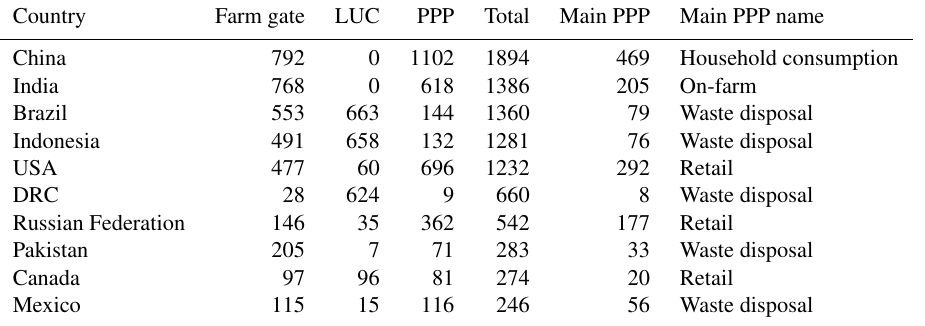
Country Farm gate LUC PPP Total Main PPP Main PPP name China 792 0 1102